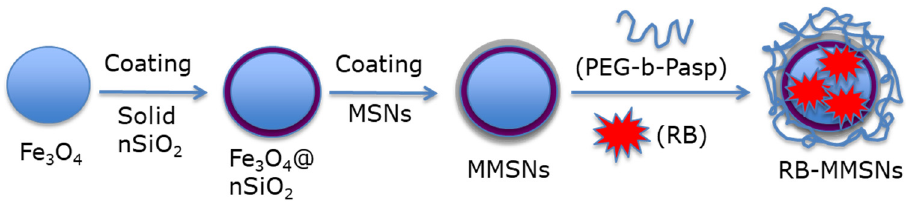
Figure 23. Viability of HeLa cells incubated with UCN/SiO 2 -RB, A@PPADT or (A + DOX)@PPADT) (100 and 200 µ g/mL) with or without laser irradiation (980 nm, 1.0 W/cm 2 , 20 min). Adapted from Zhou et al. [54].